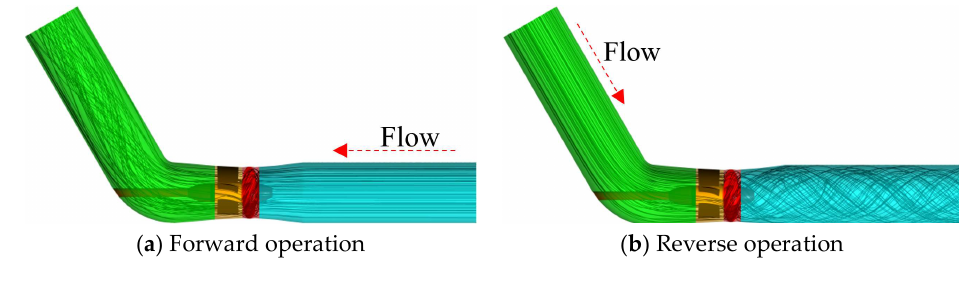
Figure 11. 1.0 Q d 3D streamline diagram.